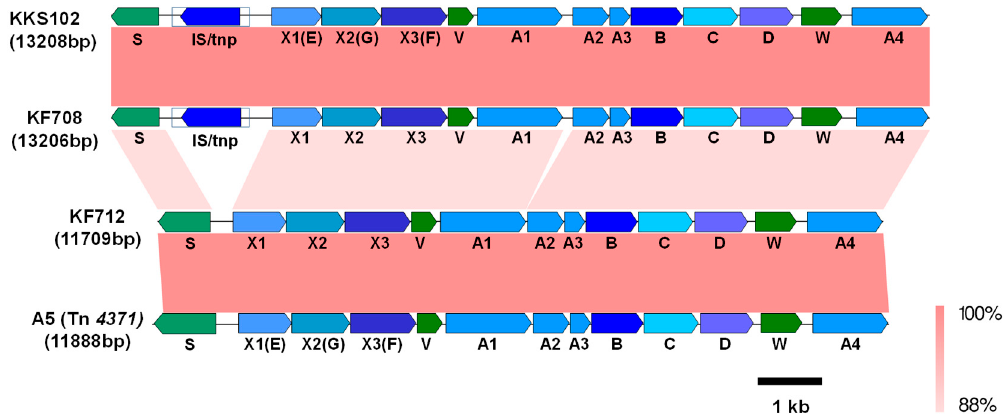
Figure 5. Comparison of the bph genes of Cupriavidus basilensis KF708 and Comamonas testosteroni KF712 belonging to group IV (type IV) to those of Acidovorax sp. KKS102 and Cupriavidus oxalacticus A5. The identities (88–100%) between the gene clusters are shown by shading in pink to red as indicated at the right bottom of the figure. E, bphE ; F, bphF ; G, bphG ; S, bphS ; V, bphV ; W, bphW ; IS, insertion sequence; tnp, transposase. The bphE, bphF, and bphG of KKS102 / Tn 4371 are homologous genes of bphX1, bphX3, and bphX2 of KF708 / KF712, respectively. The other signs are defined in the legend in Figure 4.